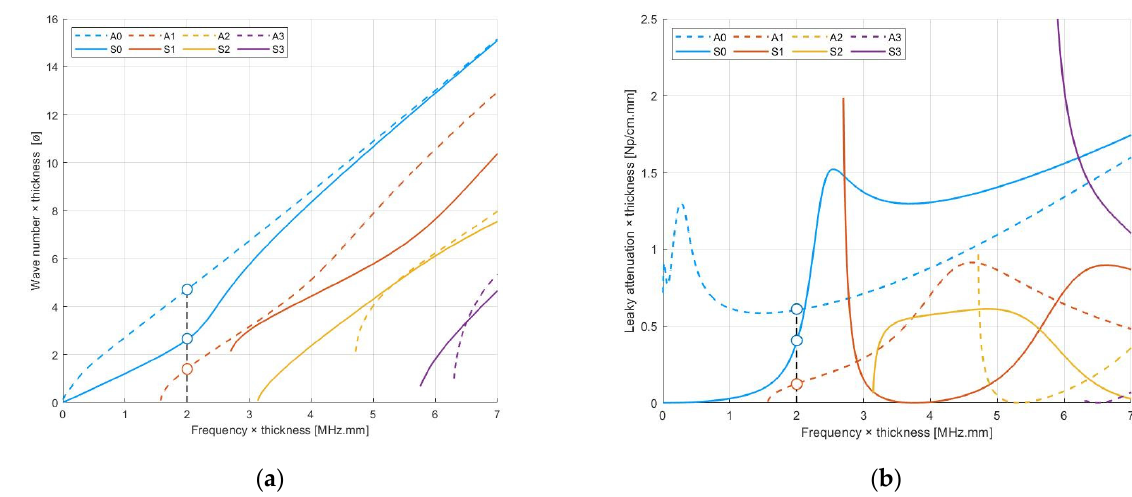
Figure 2. ( a ) Wave number of leaky Lamb waves normalized by the plate thickness; ( b ) Attenuation of leaky Lamb waves, as a function of the product frequency × thickness.